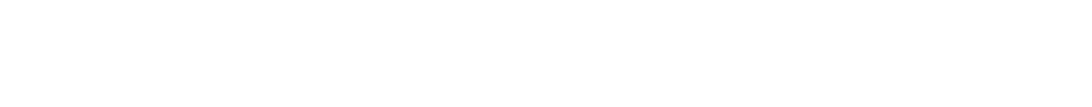
FIGURE 2 |Variation in activation strength attributable to pre-processing choices. Images are presented in neurological orientation, with the left hemisphere displayed on the left. Note that color scales differ across